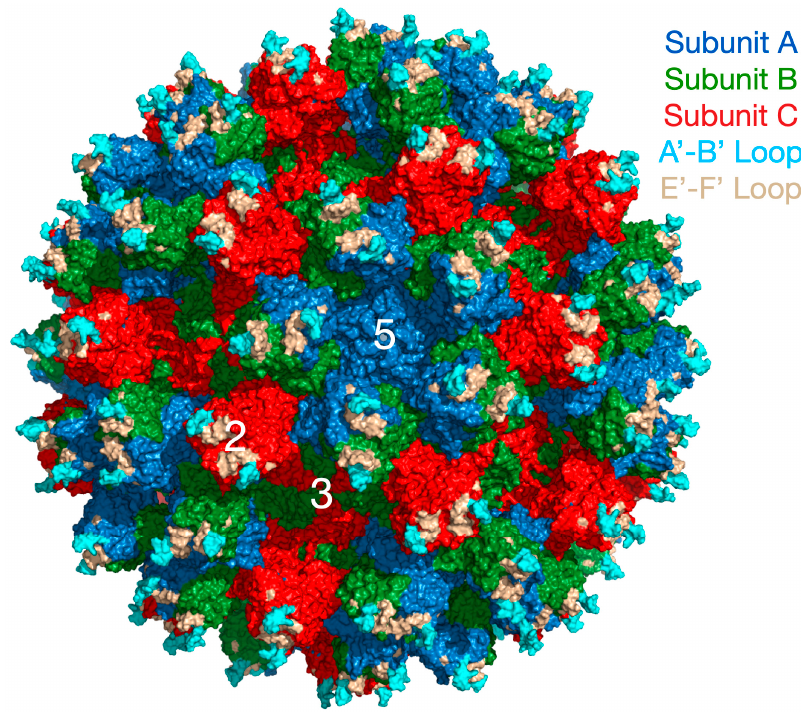
Figure 1. Overall architecture of the Calciviruses. This figure shows the entire capsid of mouse 49 norovirus (MNV) based on the cryo-EM structure (PDB:6CRJ, [14,20]). The subunits A, B, and C are 50 shown in blue, green, and red, respectively. The P domain dimers are composed of A and B around the 51 5-fold axes and of C dimers at the 2-fold axes. Also highlighted are the A’–B’ (cyan) and E’–F’ (tan) 52 loops discussed in the text. 53